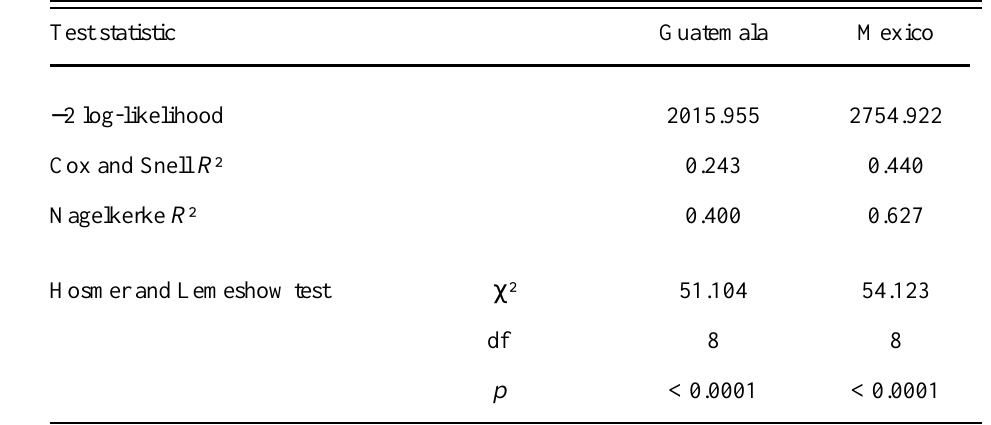
Table 3. Summary of logistic regression analyses for Guatemala and Mexico showing, in both cases, a significant predictive value for future susceptibility to deforestation established by independent explanatory